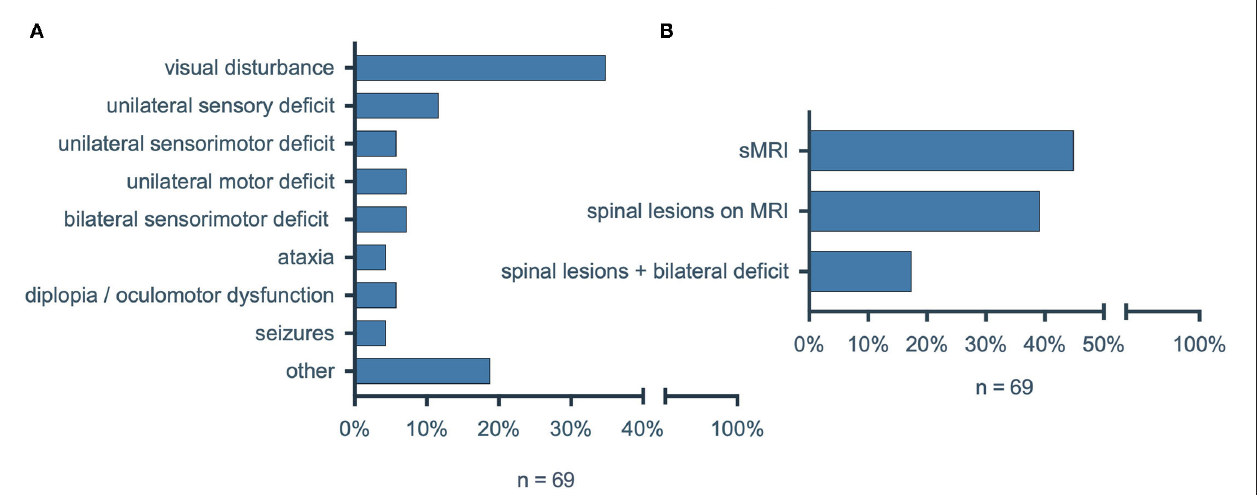
FIGURE 6 | (A) Leading symptoms of patients with multiple sclerosis in the emergency department. (B) Percentage of MS patients who received spinal MRI during hospitalization, with detected spinal lesions on MRI and with diagnosed spinal lesions on MRI and a new or preexisting bilateral sensorimotor deficit. MS, multiple sclerosis; sMRI, spinal magnetic resonance